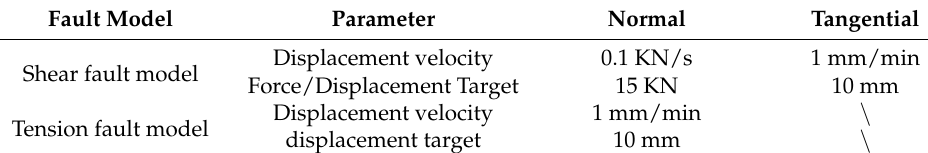
Figure 2. RJST-616 Shearing device.